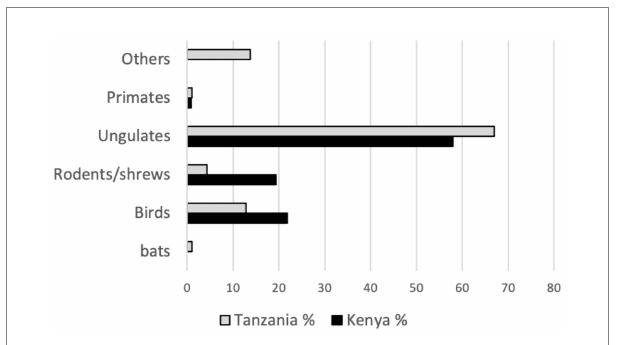
FIGURE 5 Animal groups that were bought most over the previous